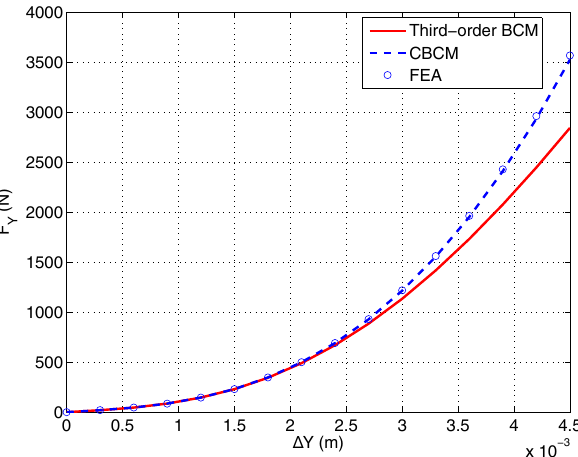
Figure 2. A fixed-guided beam in compliant parallelogram mecha- nism. Table 2. Geometric parameters of the compliant parallelogram mechanism. H is the out-of-plane thickness of the beam.